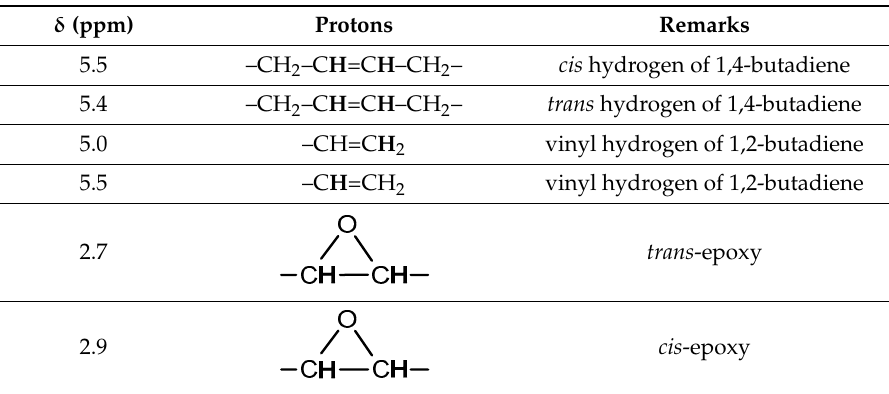
Figure 3. Spectra of eKraton ( top ) compared with Kraton D1101 ( bottom ); solvent: CDCl 3 . Table 1. Assignment of chemical shift values ( δ ) in the 1 H ‐ NMR spectrums of the virgin Kraton and eKraton [37].